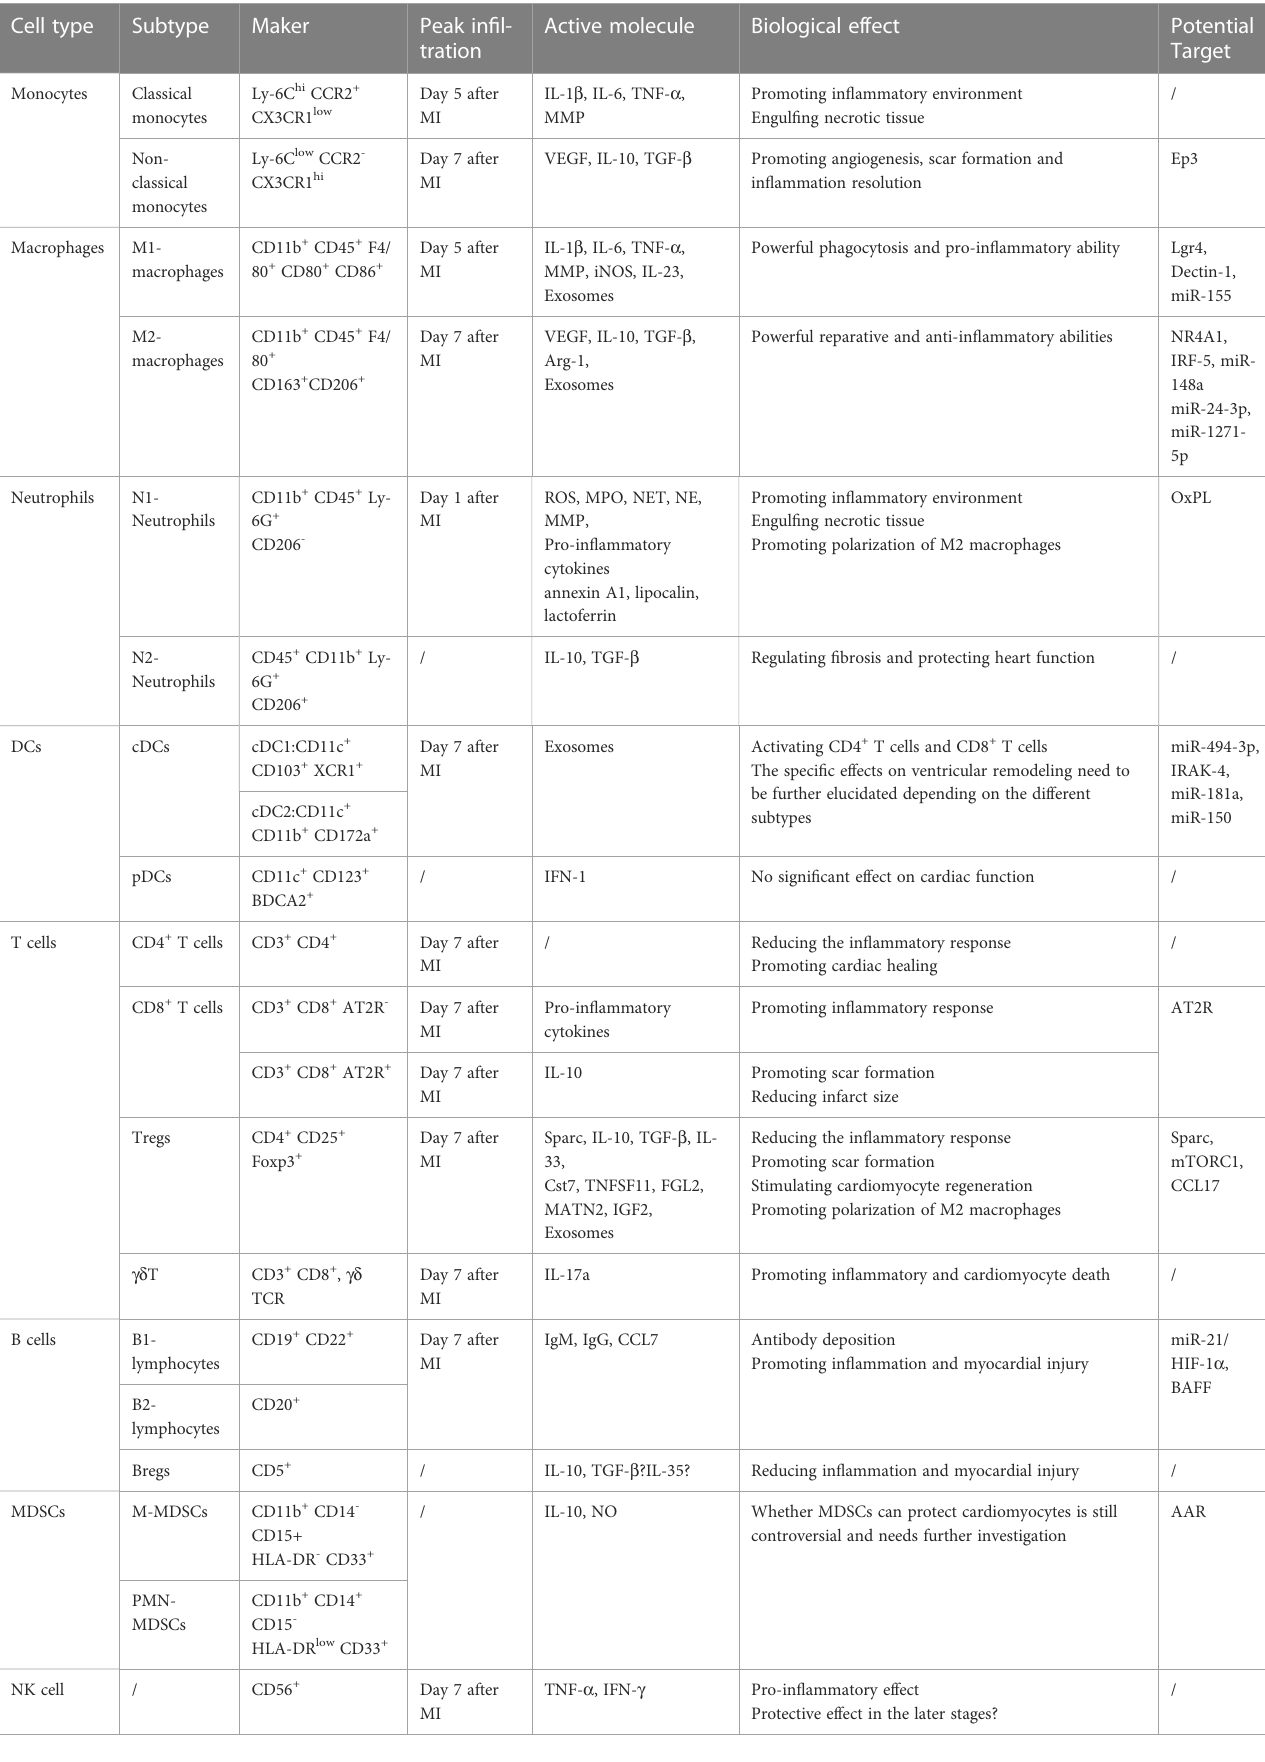
TABLE 1 Characteristics, functions, and potential targets of various immune cells involved in post-myocardial